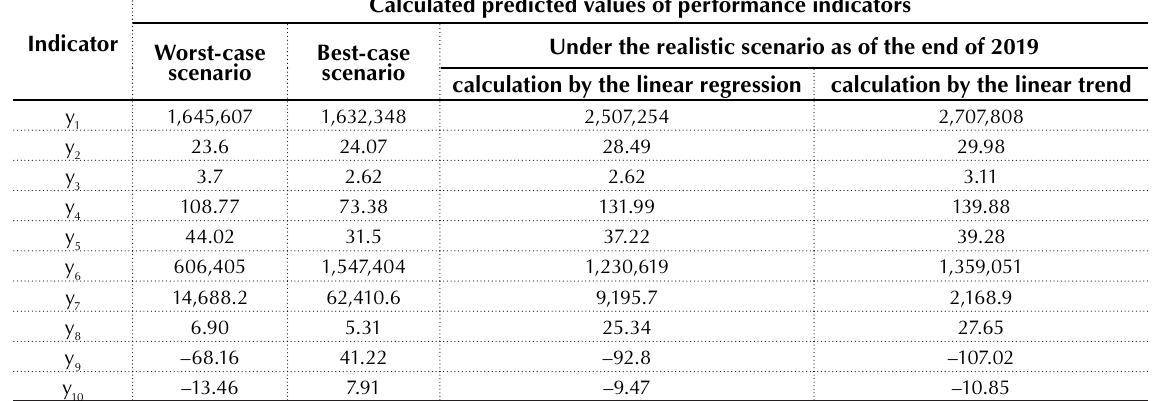
Table 4. The results of predicting the influence of foreign banking indicators on the basic indicators of financial and economic security of